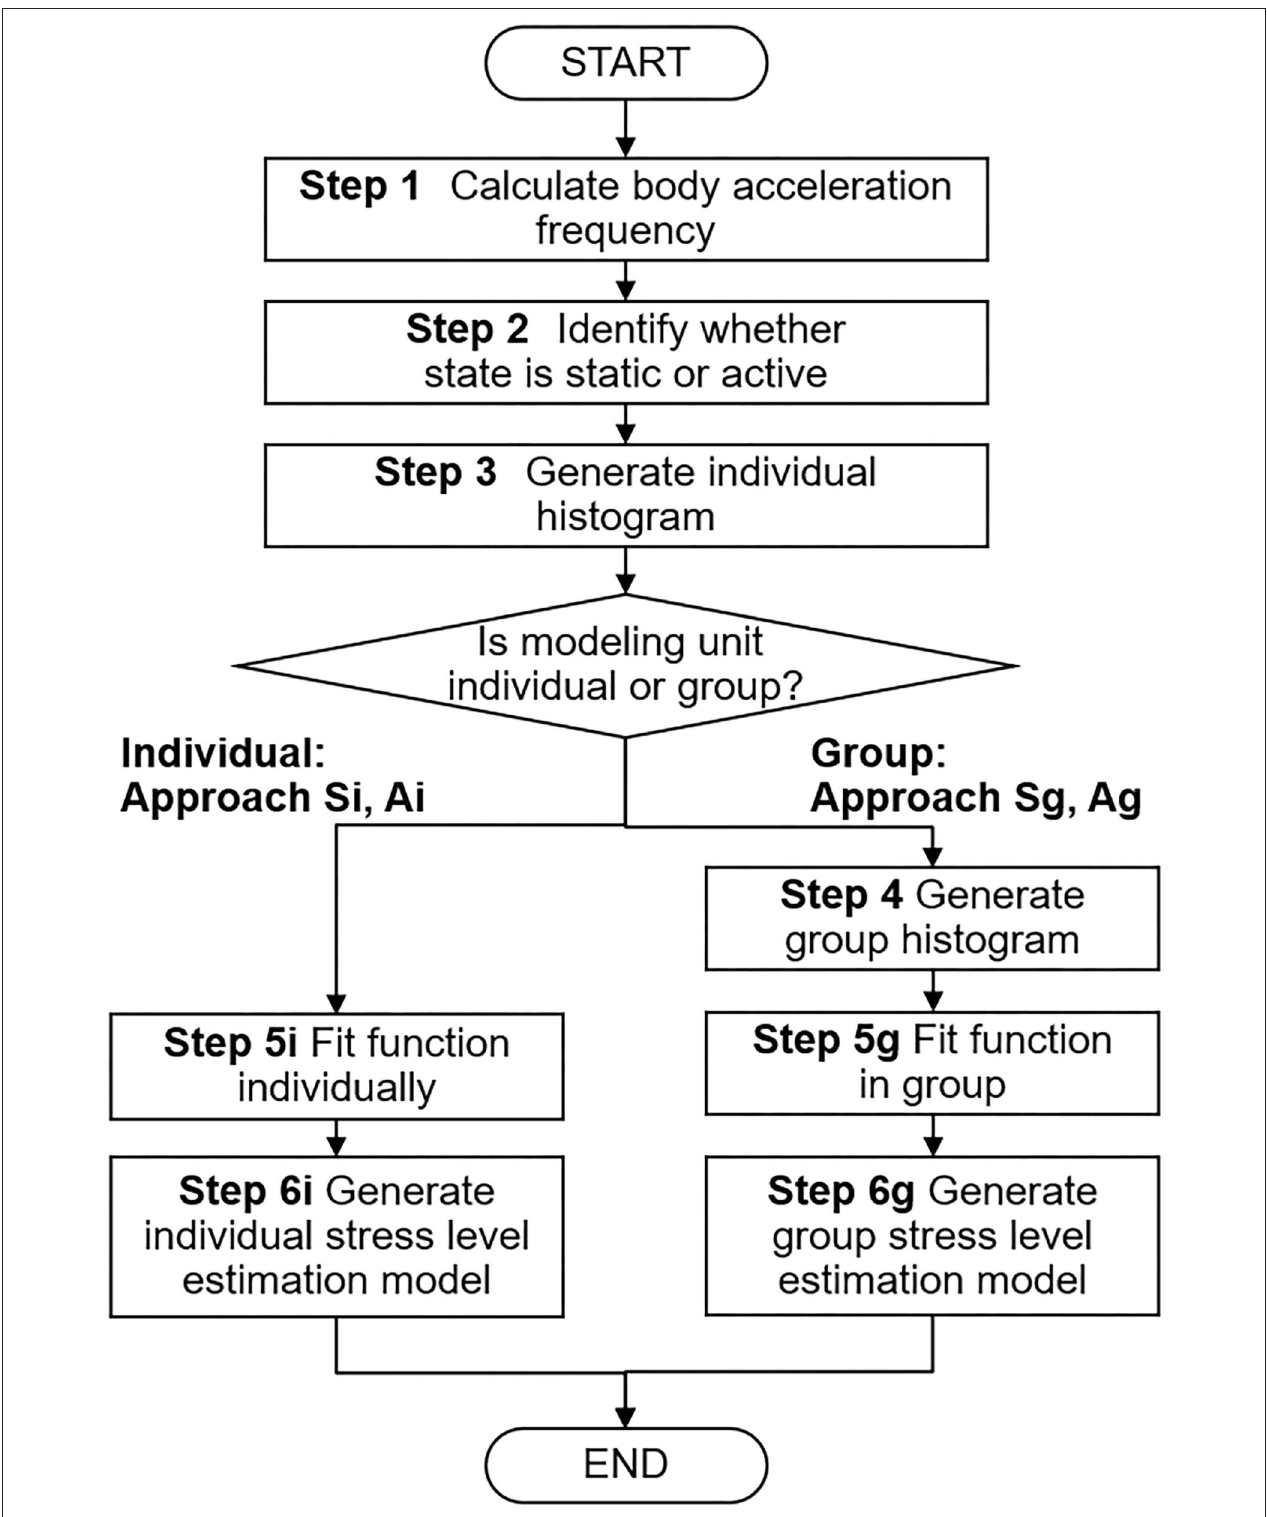
FIGURE 1 | Flowchart of four approaches to estimated model generation. Individual unit models (approach Si or Ai) proceed to Steps 1, 2, 3, 5i, and 6i, and group unit models (approach Sg or Ag) proceed to Steps 1, 2, 3, 4, 5g, and 6g. In Steps 5i and 5g, approaches Si and Sg use power law, and approaches Ai and Ag use stretched exponential function for function